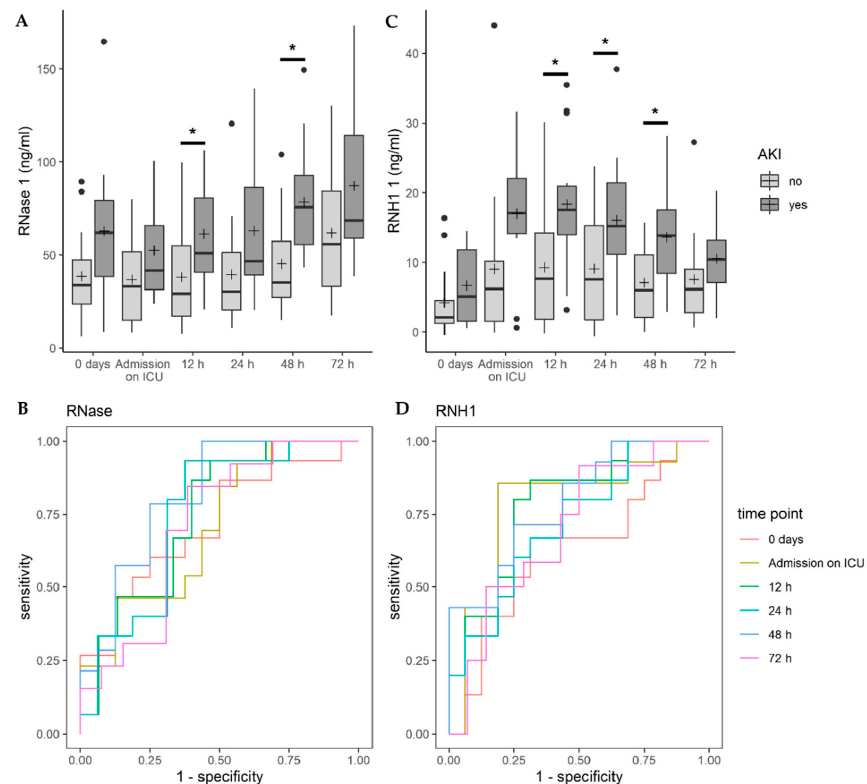
Figure 4. The correlation of ( A ) RNase 1 and ( C ) RNH1 with acute kidney injury (AKI). Data are presented as box-whisker plots. Lines inside the boxes represent the median and the pluses represent the mean. The box is defined by Q1 and Q3. The whiskers range from Q1 to Q1 + 1.5 ∗ (Q3 − Q1) and Q3 to Q3 − 1.5 ∗ (Q3 − Q1), with observations outside of the whiskers shown as points classified as outliers. ROC analysis of the diagnostic accuracy of ( B ) RNase 1 and ( D ) RNH1 serum levels for acute kidney injury in patients undergoing endovascular or open TAAA repair. * p < 0.05; RNase,